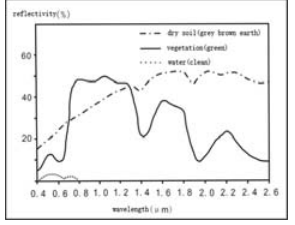
Figure 1. Spectral curve of typical objects